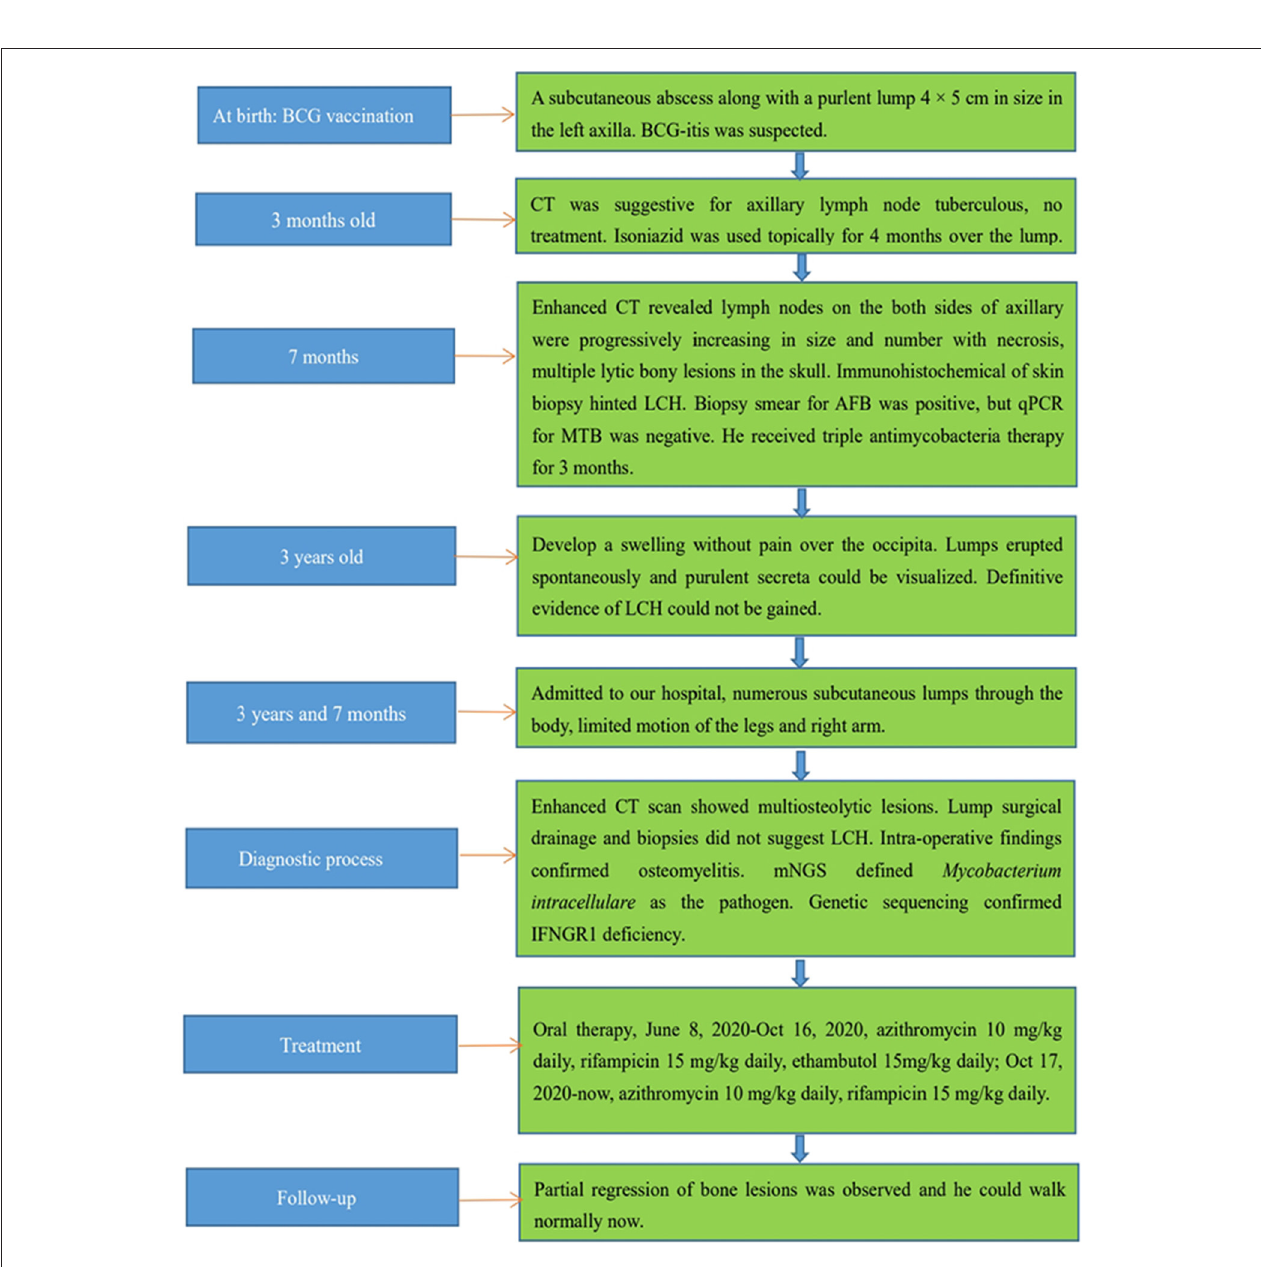
FIGURE 3 | Sequencing of the interferon-gamma receptor-1 gene of the patient.